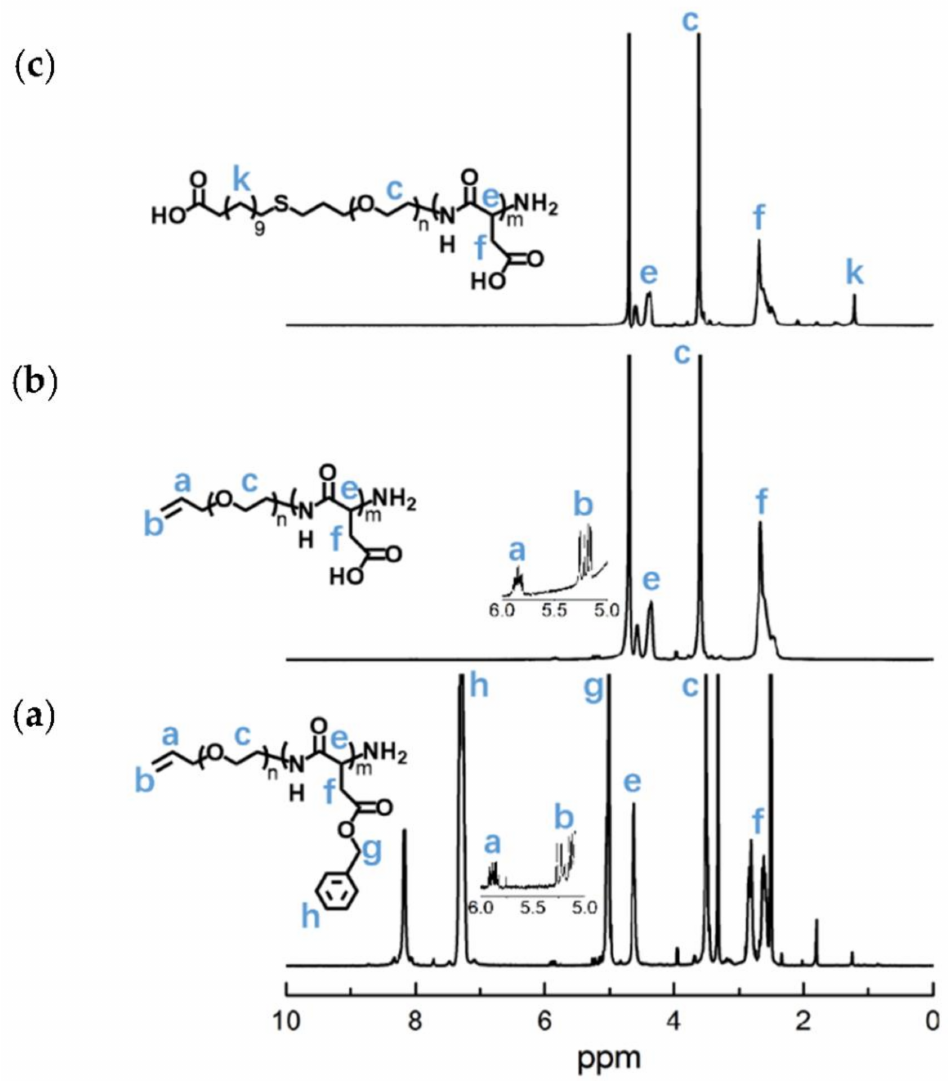
Figure 10. 1 H-NMR analyses of ( a )APEG-PBLA, ( b ) APEG-PAsp, and ( c )